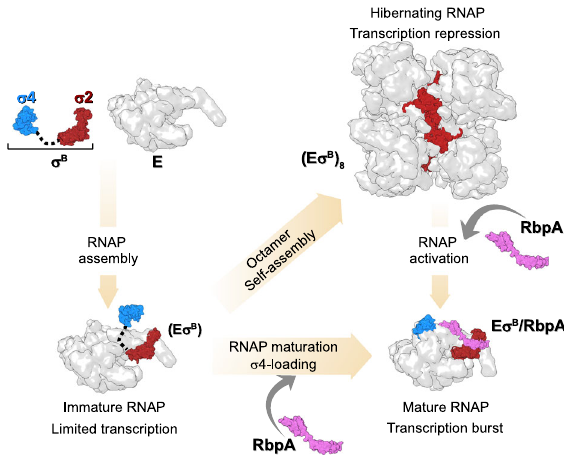
Fig. 7 | Model depicting transcription regulation through E σ B holoenzyme assembly and oligomerization. A pathway to Mtb E σ B maturation. The pathway starts with the formation of the immature RNAP holoenzyme from free σ B [ σ 2 domain (dark red) and σ 4 domain (cyan)] and RNAP core (E, depicted as a gray molecular surface). In the immature E σ B , the σ B domain 4 remains unloaded from the RNA exit channel, thus making it prone to oligomerization. Binding of RbpA (depicted as a pink molecular surface) to E σ B prevents oligomerization and con- vertsE σ B tothetranscriptionallyactive,matureformwiththe σ B domain4loadedin the RNA exit channel. Binding of RbpA to the (E σ B ) 8 octamer induces its